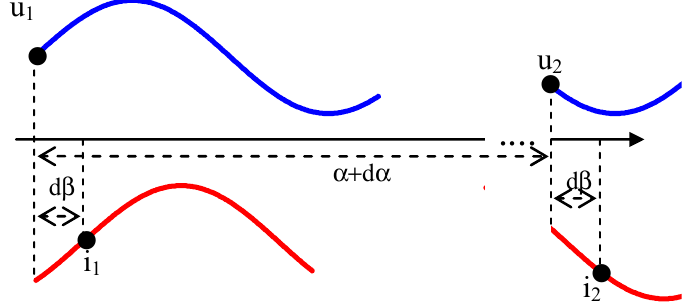
Figure 1. Series sampling; d β , d α —angular delays of samples readout.